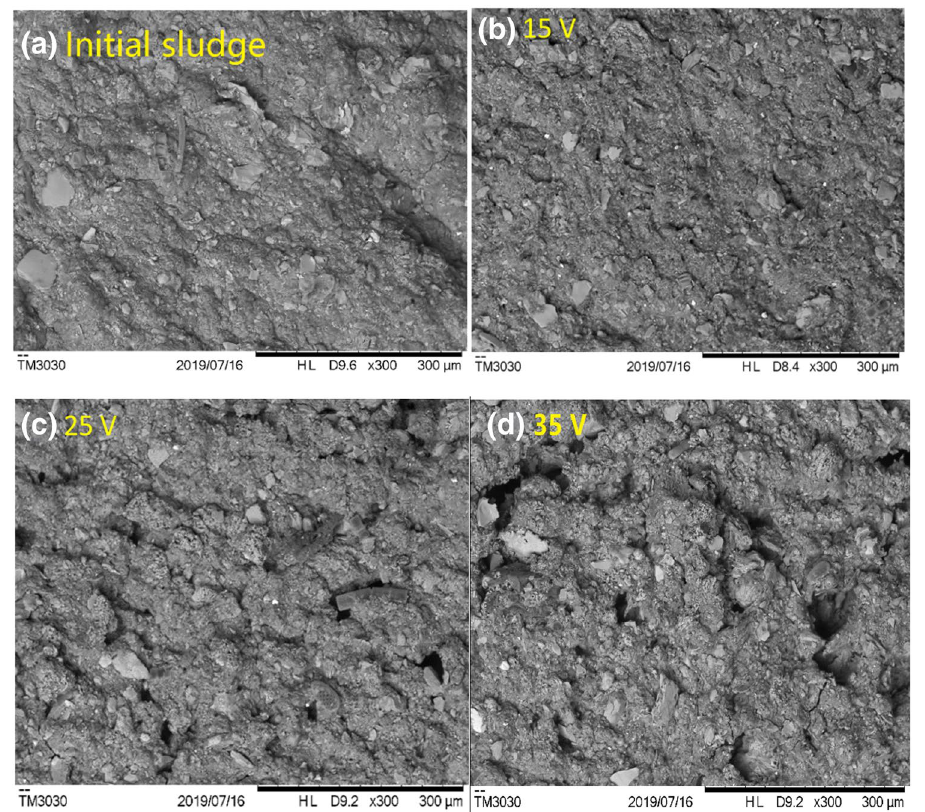
Figure 6. SEM micrographs of electro-dewatering sludge under different